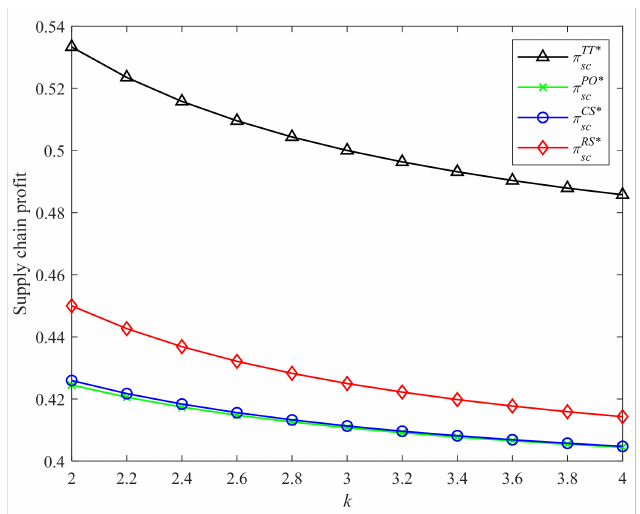
Figure 5. Comparison of the supply chain profits with different k